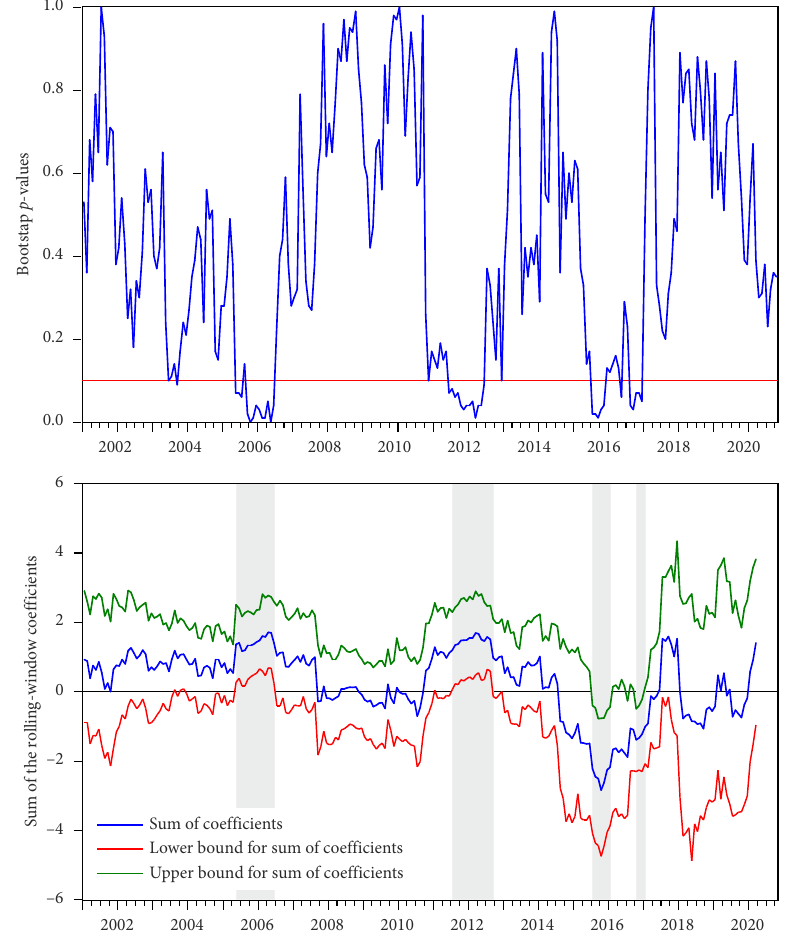
Figure 3. Impact of GP on